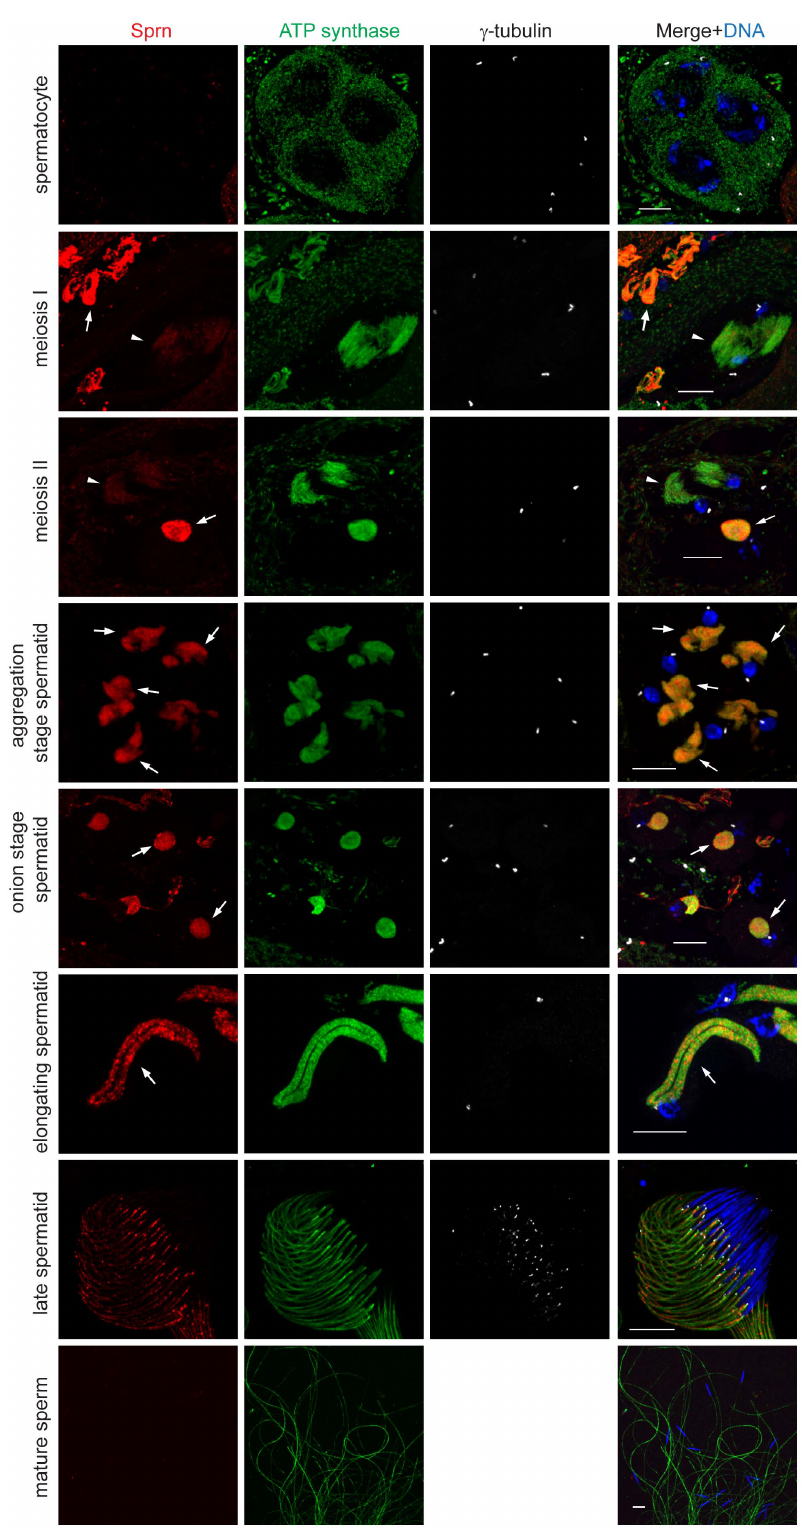
Figure 2. Sprn is expressed in the nebenkern throughout spermatid elongation. Endogenous Sprn expression is first detectable, though weak, in meiosis I and II, when mitochondria form first aggregates (arrowheads). Sprn expression increases at the spermatid nebenkern and persists throughout spermatid elongation (arrows), but is absent in mature sperm. ATP-synthase labels inner membranes of mitochondria. c -tubulin labels the centriole as follows: in each spermatocyte, there are two v-shaped centriole pairs (four centrioles); in meiosis I, each daughter cell has one pair of centrioles (two centrioles); in meiosis II, each daughter cell has one centriole and after meiosis, each spermatid has only one centriole. Scale bars, 10 m m. doi:10.1371/journal.pone.0108802.g002 PLOS ONE |